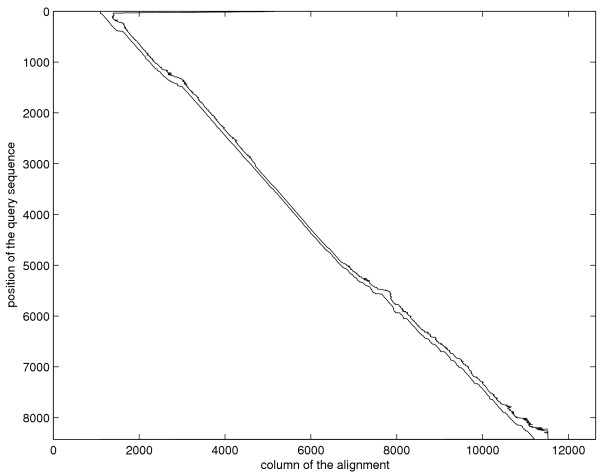
Reduction of active states for a set of HIV test sequences using the beam-search heuristics [32, 33]. In this example, we have 14 (sub-)subtypes each of which has three states per alignment column (match, delete and insert). Thus, a column corresponds to 14 × 3 = 42 states. The beam-search algorithm reduces the number of active states considerably; the figure indicates for each position in the query sequence those columns that contain active states. Thus, instead of considering the entire dynamic-programming matrix, our algorithm needs to consider only the small strip between the two lines. We used a beam width of ℬ
 MathType@MTEF@5@5@+=feaafiart1ev1aaatCvAUfKttLearuWrP9MDH5MBPbIqV92AaeXatLxBI9gBamrtHrhAL1wy0L2yHvtyaeHbnfgDOvwBHrxAJfwnaebbnrfifHhDYfgasaacH8akY=wiFfYdH8Gipec8Eeeu0xXdbba9frFj0=OqFfea0dXdd9vqai=hGuQ8kuc9pgc9s8qqaq=dirpe0xb9q8qiLsFr0=vr0=vr0dc8meaabaqaciaacaGaaeqabaWaaeGaeaaakeaaimaacqWFSeIqaaa@377E@ = 10-20 and a jump probability of 10-9.